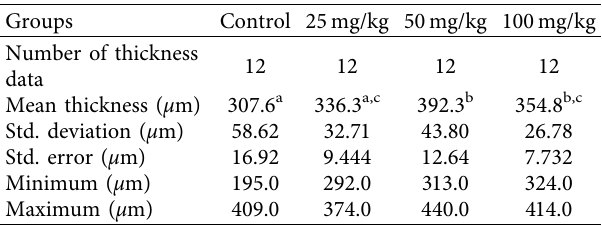
Figure 6: Bar chart showing mean values of the periodontal lig- ament (PDL) thickness in the teeth of Wistar rats after 60 days of CaO-NP administration at different dosages (25, 50, and 100mg/ kg) and the nontreated control group. Horizontal lines connecting two bars indicate statistical significance ( P < 0 . 05). Table 3: Mean values of PDL thickness in the teeth of Wistar rats after 60 days of CaO-NP administration at different dosages (25, 50, and 100 mg/kg) and the nontreated control